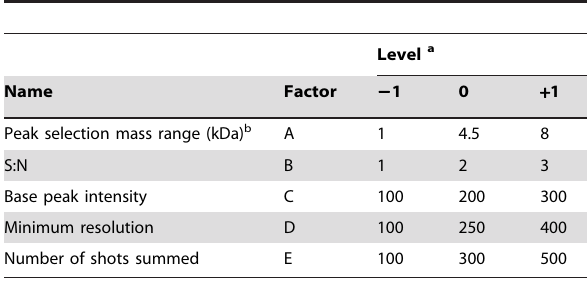
Table 1. Factors and levels used in the fractional factorial experimental design.